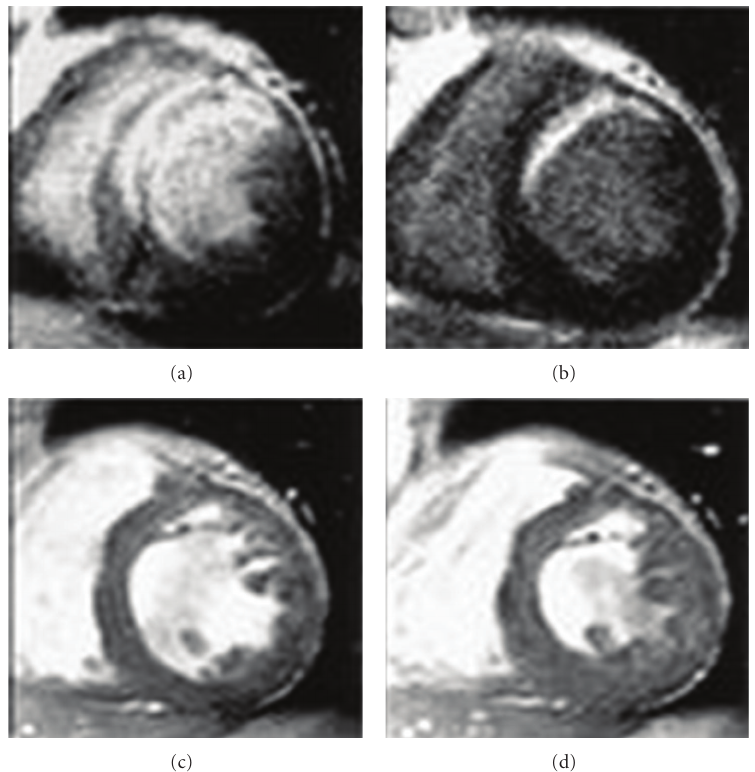
Figure 1: Contrast-enhanced magnetic resonance images in the acute state (a) and chronic state (b), and cine images in the chronic state (c, diastole; d, systole) in Patient who sustained an anteroseptal myocardial infarction. The contractility of the anteroseptal wall was not improved in the chronic state in this patient (with permission from Ichikawa et al.(2005), Am Coll Cardiol, Elsevier Inc.,